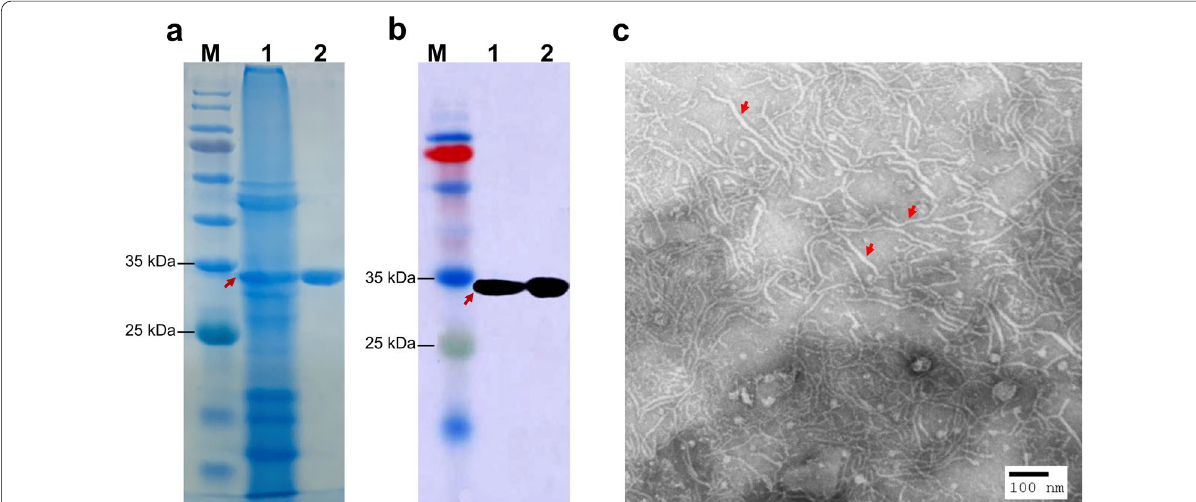
Fig. 1 Purification of RSV. a SDS-PAGE analysis of the purified RSV RNPs. Lane 1, crude RSV preparations obtained previously (Lin et al. 2020) were used as a control; Lane 2, RSV RNPs purified in this study. 10 µL of RSV preparations were loaded into each well. The gel was stained with Coomassie brilliant blue after electrophoresis. The arrows indicate the band with a size corresponding to RSV NP. M, molecular maker. b Western blotting analysis of the NP of RSV. After separation by SDS-PAGE, the proteins of the RSV preparations were transferred onto a nitrocellulose membrane and the blot was probed with an antiserum against RSV NP followed by a goat anti-rabbit IgG conjugated with HRP. c Observation of RSV via transmission electron microscopy. Red arrows indicate representative RSV RNPs. Scale bar, 100 nm